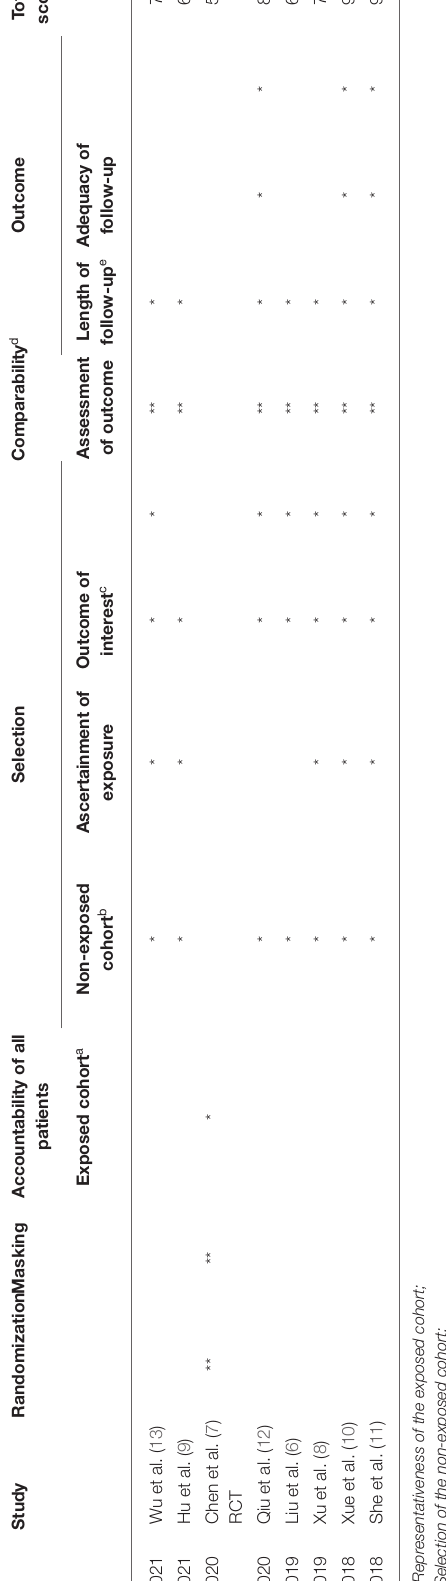
segmentectomy to thoracotomy or lobectomy) (mean